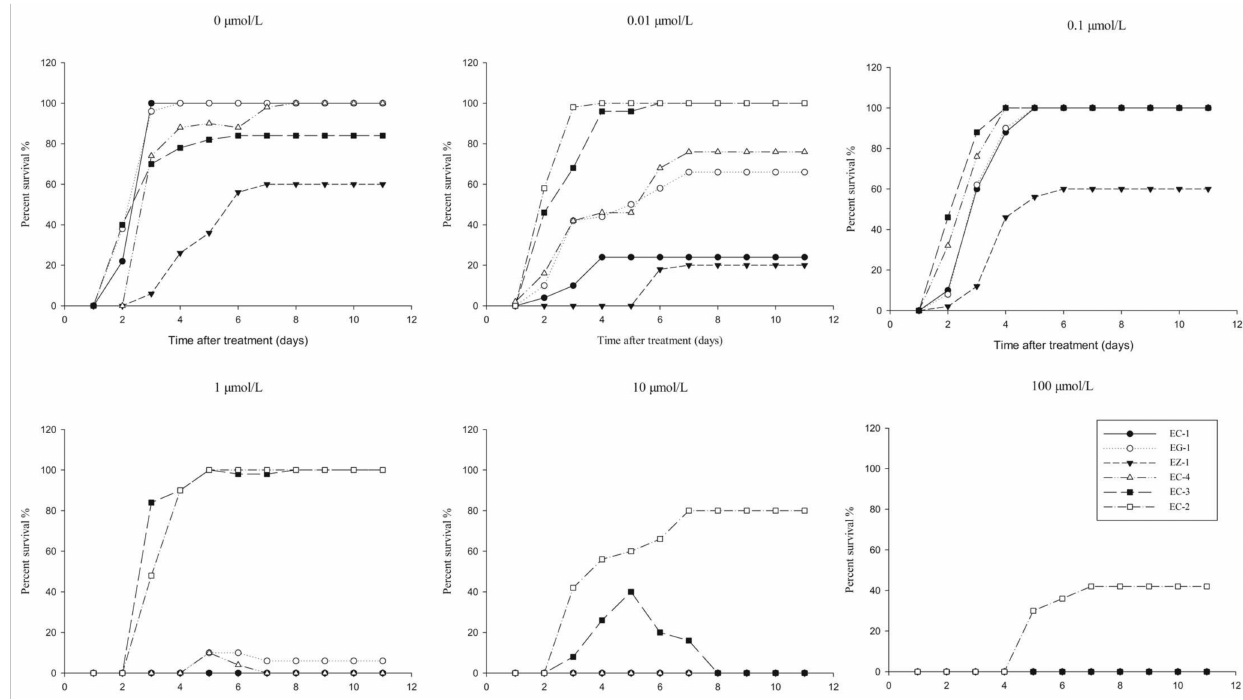
Figure 1. Percentage of daily survival of various biotypes at different penoxsulam concentrations (%).